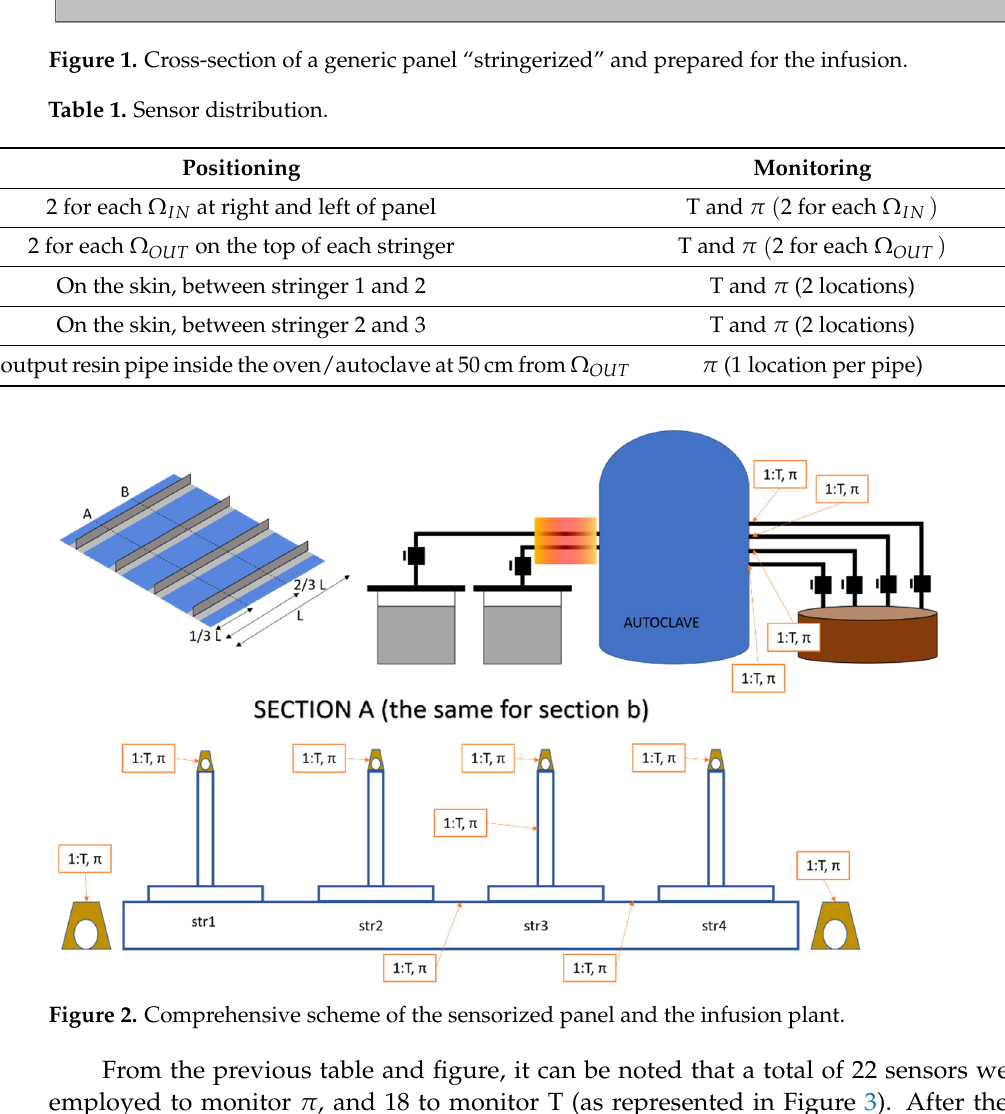
Figure 2. Comprehensive scheme of the sensorized panel and the infusion plant.